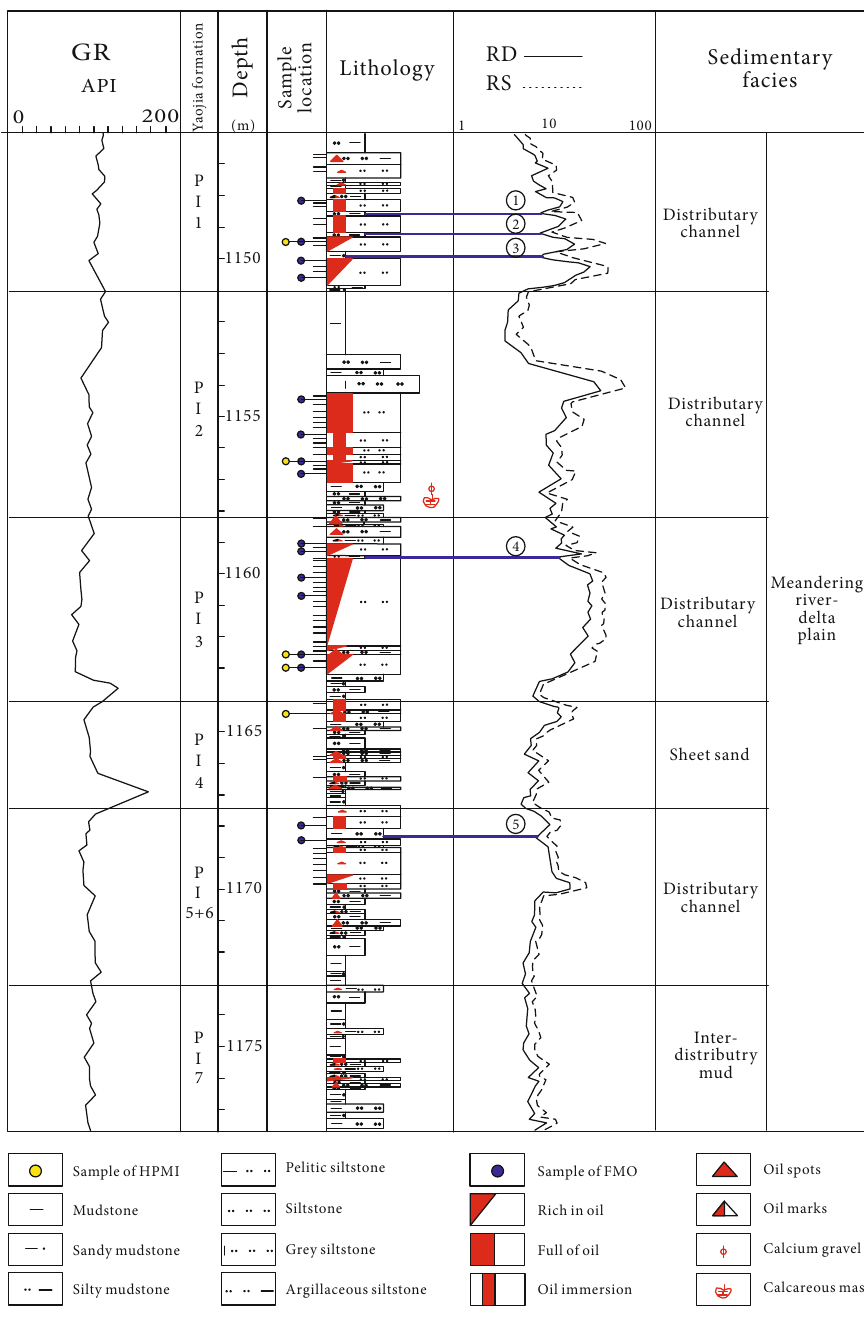
Figure 2: Well B2-60-GB271 lithologic log in PI1 layer. The PI1 layer is in Yaojia Formation, which belongs to the Cretaceous system, one of the main reservoir in northern Songliao